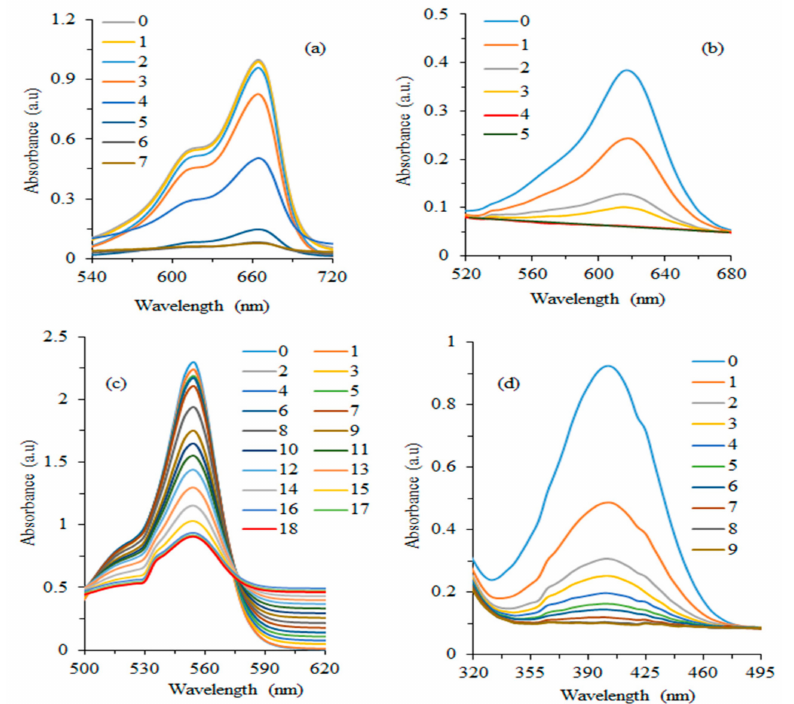
Figure 10. Catalytic reduction of various dyes (0.072 mM) such as ( a ) Mb, ( b ) MG, ( c ) RhB and ( d ) 4-Np in the presence of biogenic CAg-nPs catalyst (2.1 mg / mL) and NaBH 4 (7.88 mM) at an ambient temperature.